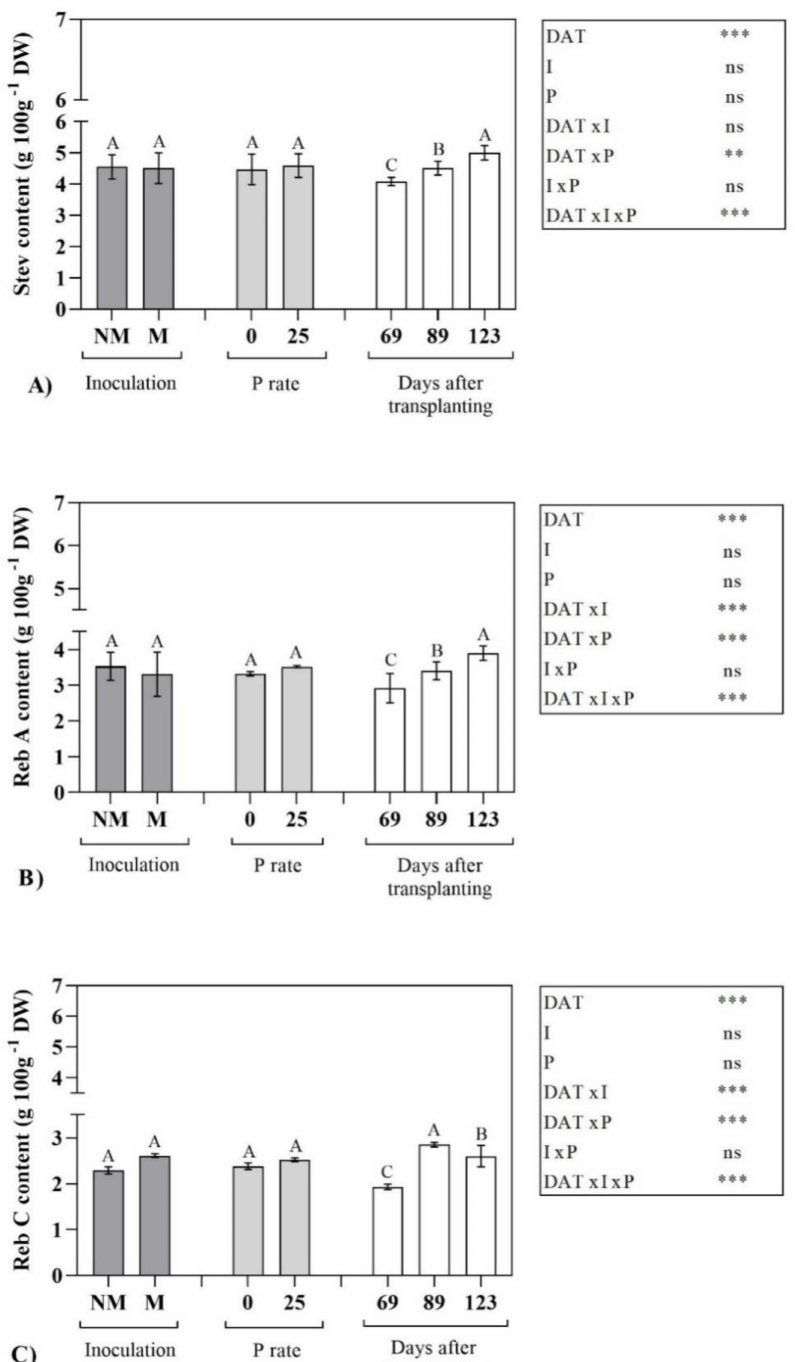
Figure 1. E ff ect of inoculation (I), P rate (P) and days after transplanting (DAT) on the content (g 100g − 1 DW) of Stevioside ( A ), Rebaudioside A ( B ) and Rebaudioside C ( C ) in Stevia rebaudiana Bert. leaf extracts. Means followed by the same letters are not significantly di ff erent at p < 0.05 according to L.S.D. Significance of variability factors (I, P and DAT) and their interaction are also reported, as follows: ns, not significant; **, significant at p ≤ 0.01; ***, significant at p ≤ 0.001 level. Stev, stevioside; Reb A, rebaudioside A; Reb C, rebaudioside